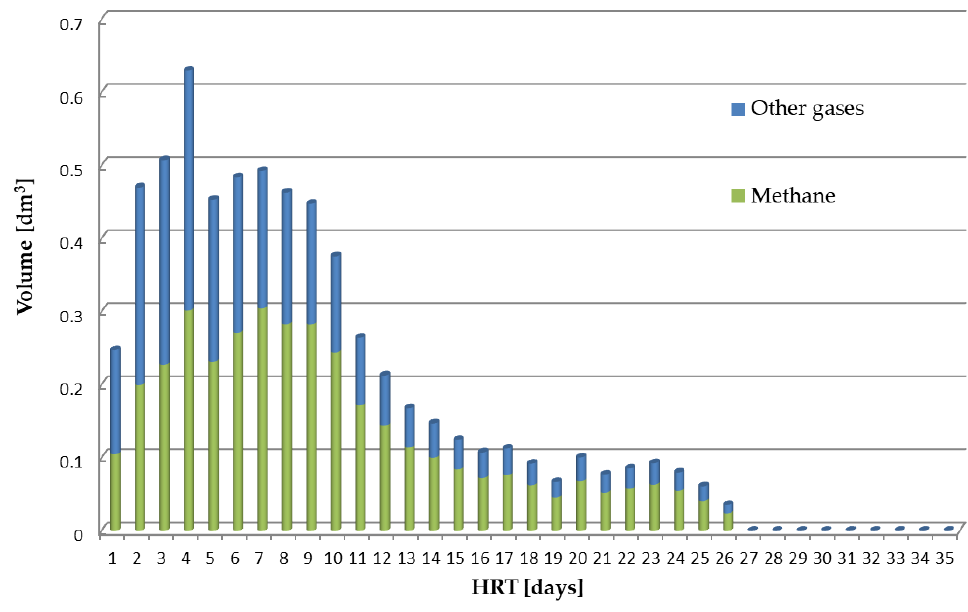
Figure 2. Graph of accumulated biogas production as a function of time.